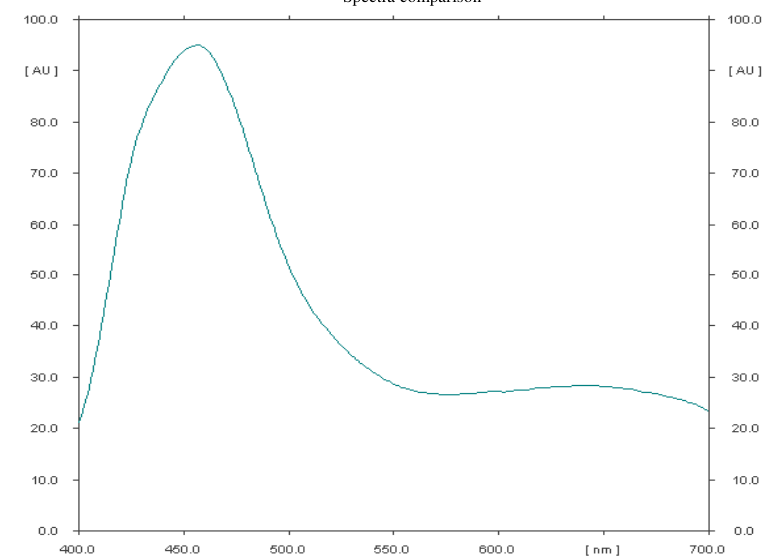
Figure 4. Absorbance spectrum of sucralose–rhodamine complex showing an absorbance maximum at 456 nm (Solvent